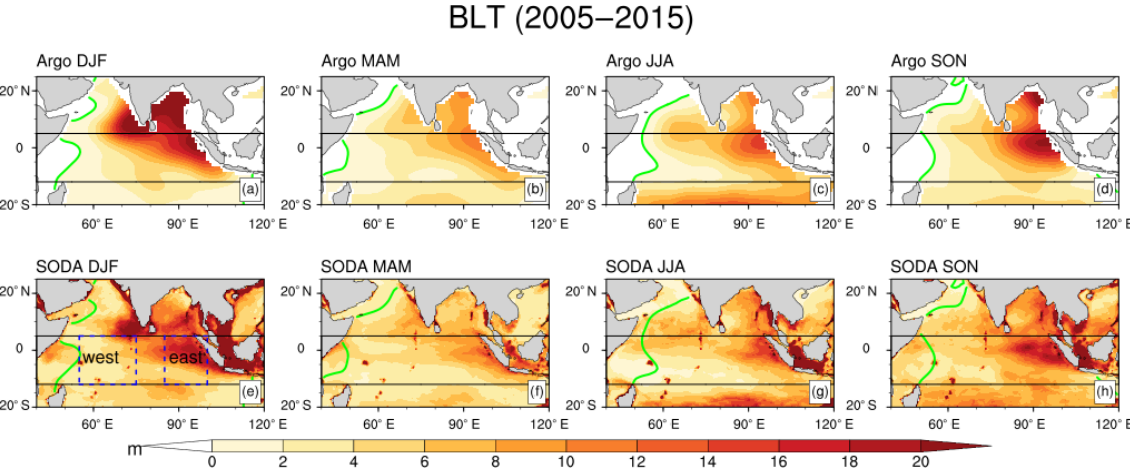
Figure 1. Seasonal distributions of the BLT climatology obtained from Argo (a–d) and SODA (e–h) from 2005 to 2015 in the Indian Ocean. Units: m. The thicker green line is the zero BLT line from Argo and the dashed blue lines represent the areas of the western TIO (5 ◦ N–12 ◦ S, 55–75 ◦ E) and the eastern TIO (5 ◦ N–12 ◦ S, 85–100 ◦ E), respectively. The two thin black lines represent the latitudes of 12 ◦ S and 5 ◦ N,